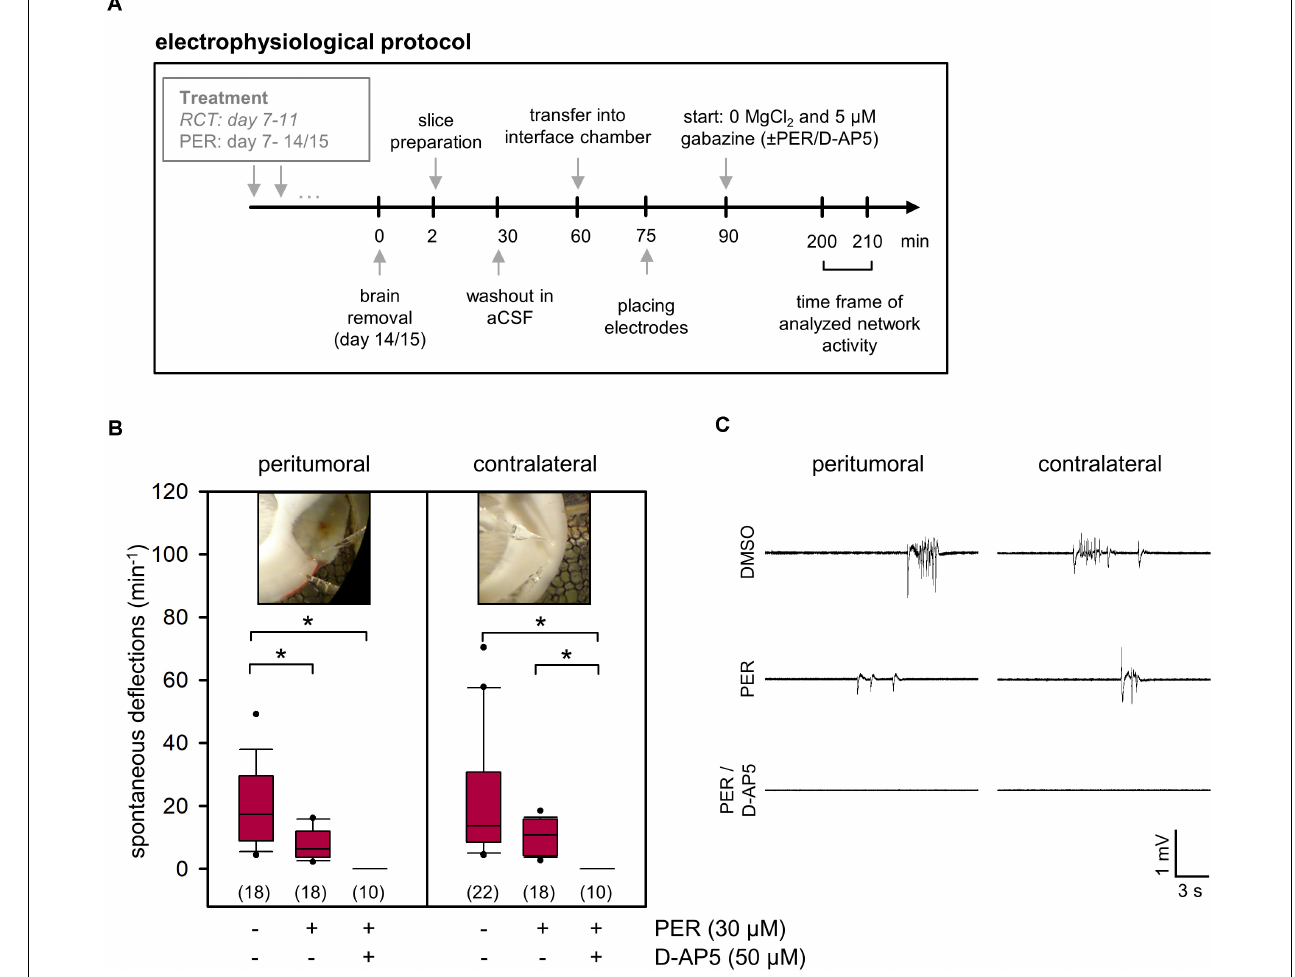
FIGURE 4 | Ex vivo effects of PER on network activity in acute F98 glioma slices. (A) Illustration of the electrophysiological protocol for investigation of PER action on network activity. (B) 1 × 10 5 F98 glioma cells were orthotopically injected into the neocortex of Fischer 344 rats. After 2 weeks the animals were sacrificed and brain slices were prepared for ex vivo application of vehicle control (DMSO), PER, NMDA receptor antagonist D-AP5, and combination thereof. Slices were challenged with aCSF with 0 µ M Mg 2 + and 5 µ M gabazine. Data are represented in box plots, n = 10–22 measurements (slices were from a total of 16 rats with F98 glioma), * p < 0.05 (Kruskal–Wallis test with post hoc Dunn’s test). Photographs indicate peritumoral or contralateral position of microelectrodes. (C) Sample traces of field potential recording illustrate deflections that were used for